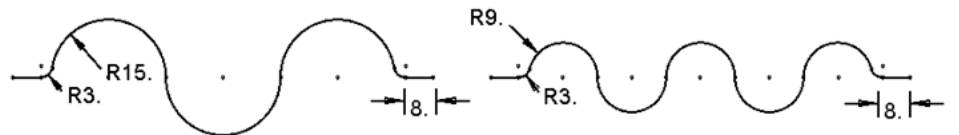
Figure 3. The schematic of the cross-sections of the sinusoidal structures with 3 curvatures ( left ) and 5 curvatures ( right ). (All dimensions are given in millimeters.)